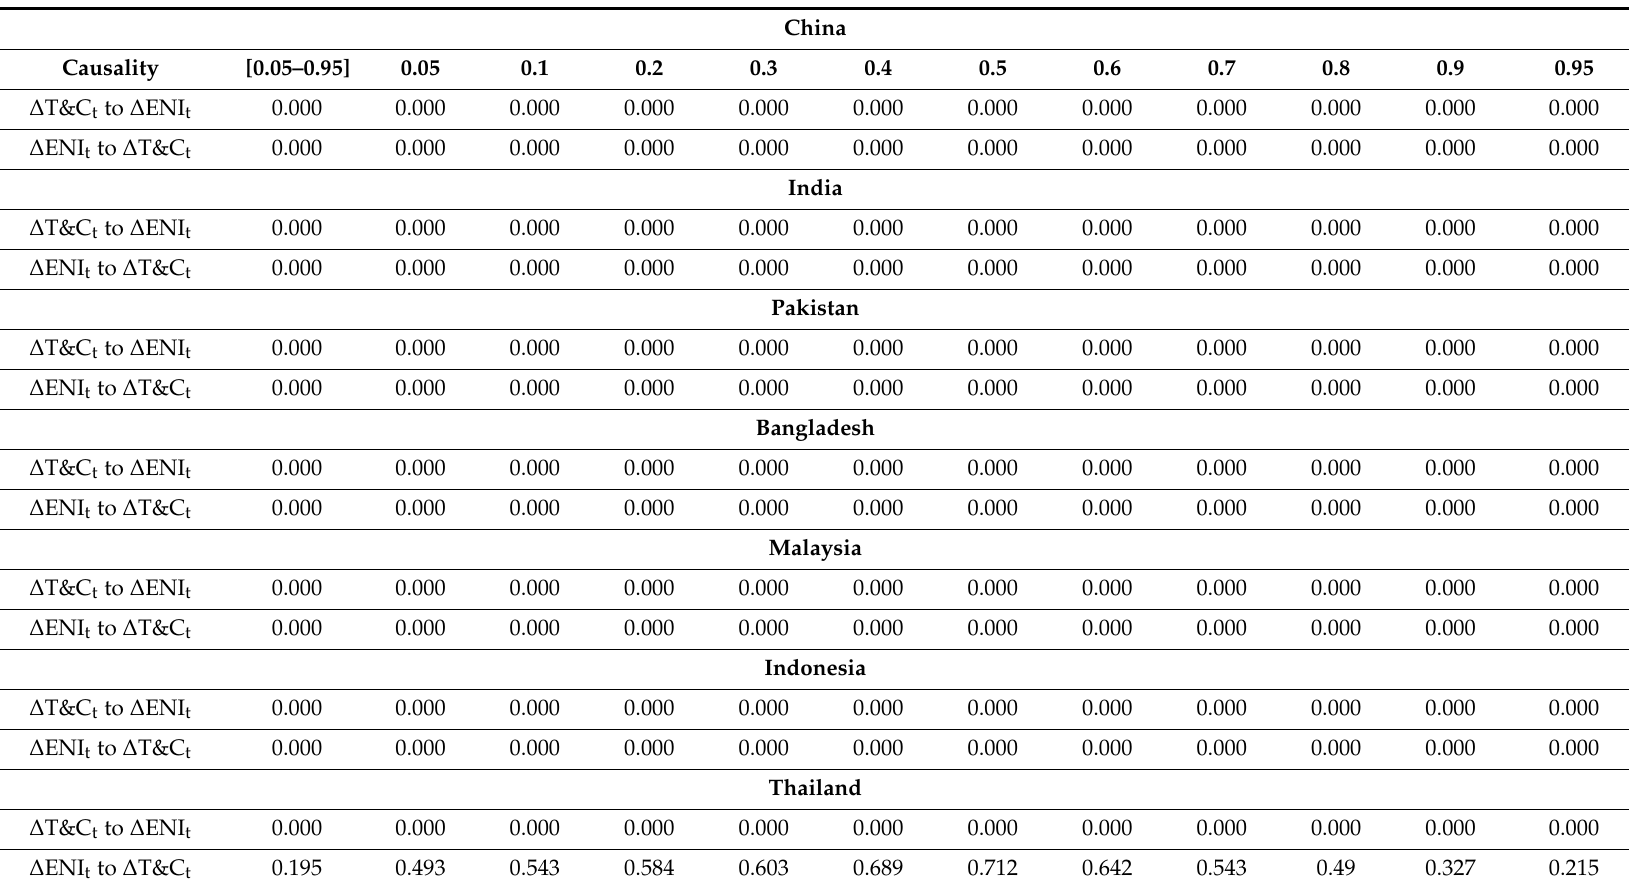
Table 5. Granger Causality in Quintile Test